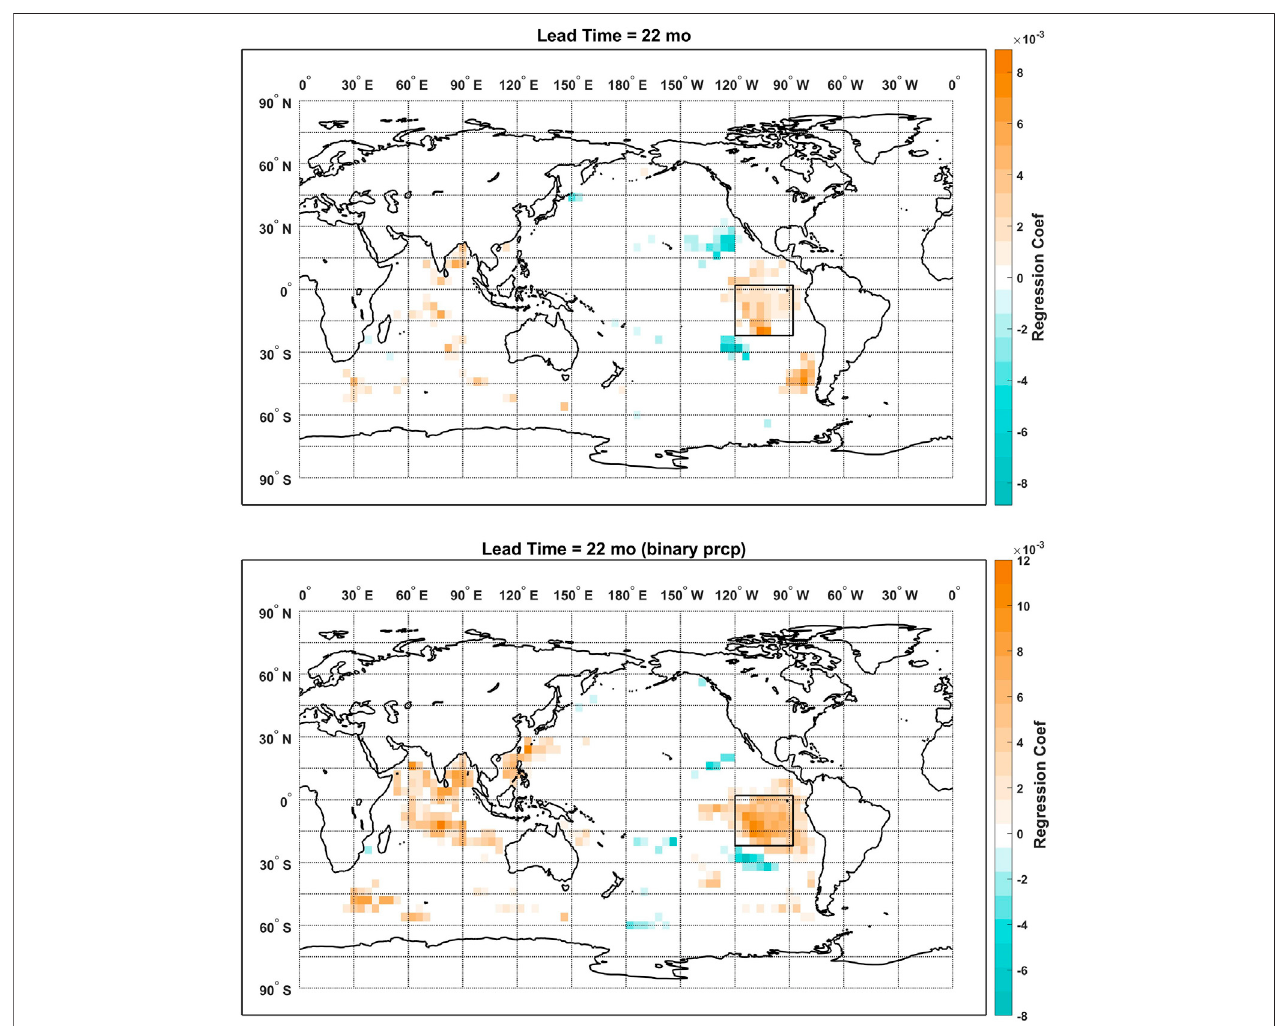
FIGURE11| Mapsofregressioncoef fi cientsfromtheelasticnetmodelsusingtrue-amplitude (top) andbinary (bottom) predictandprecipitationattheleadtimeof 22 months.